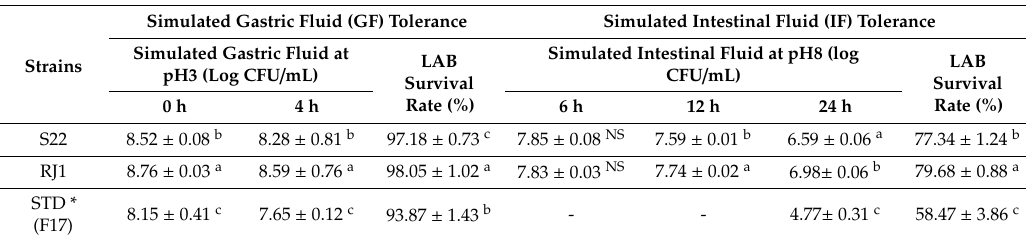
Table 1. Viable LAB counts (log CFU / mL) in simulated gastric and intestinal fluid at pH 3 and pH 8 at di ff erent time intervals (Gastric fluid (GF): 0 and 4 h; Intestinal fluid (IF): 6, 12, and 24 h). Data represent mean ± SD ( n = 3), and values within the same column with di ff erent superscript letters (a, b, c) are significantly di ff erent at p < 0.05. STD: standard LAB, NS: not significant at p < 0.05. (* Ref [20]).